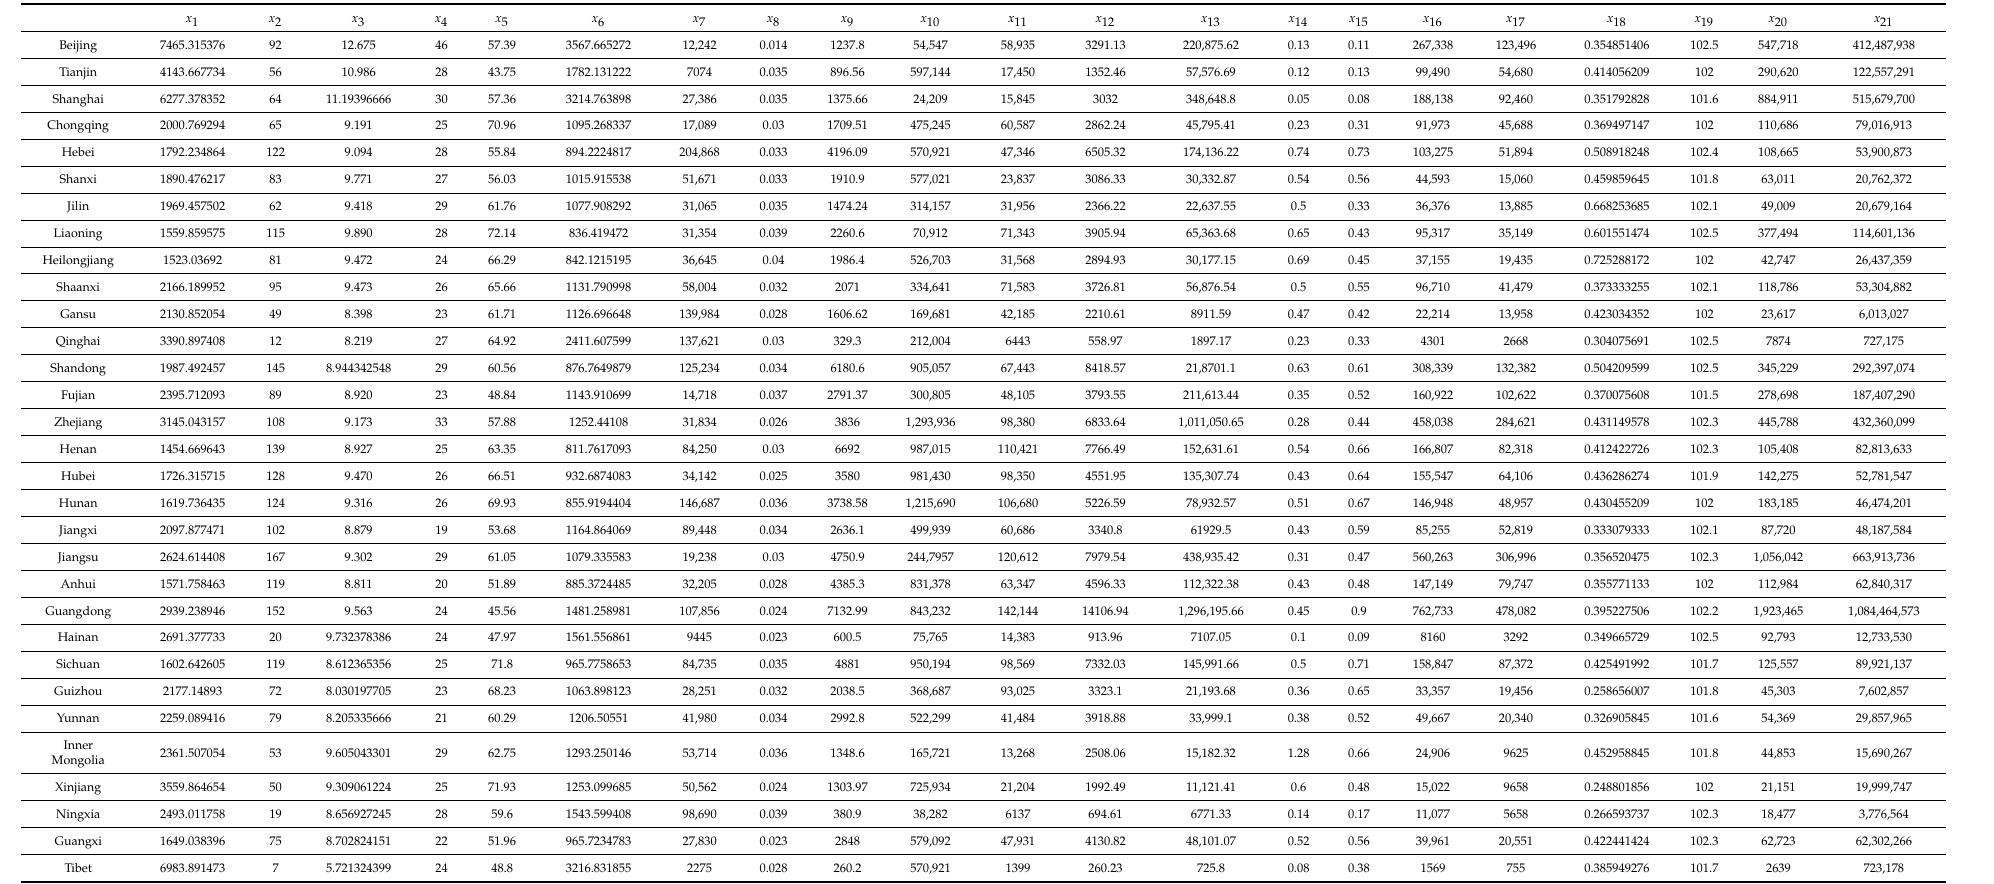
Table A7. Collected data for relevant